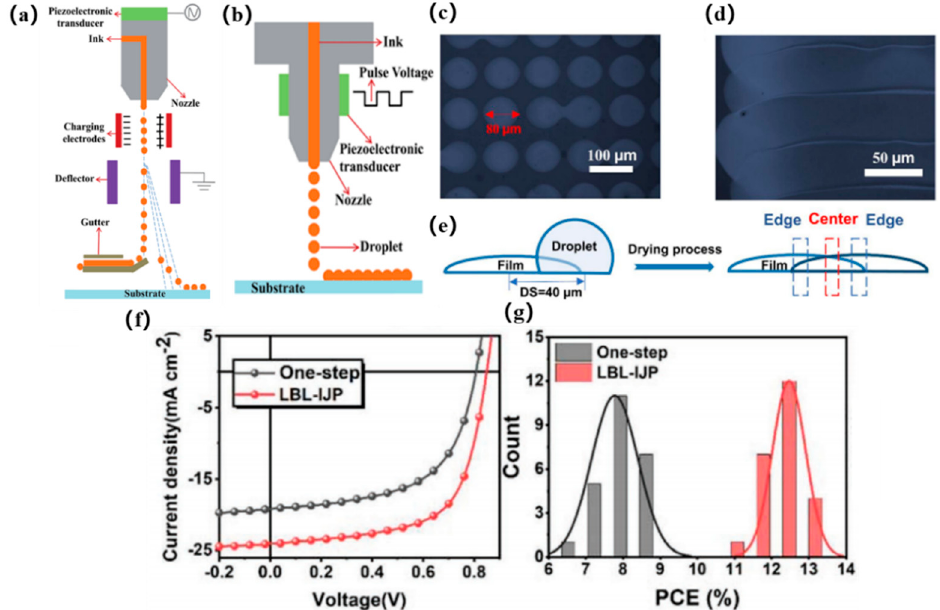
Figure 10. Schematic diagrams of ( a ) Continuous inkjet printing (CIJ), ( b ) Drop-on-demand (DOD) inkjet printing. Adapted with permission from Ref. [106]. Copyright 2019 The Royal Society of Chemistry; ( c , d ) Photographs of the ink drop and printed lines when printed at 50 ℃ . ( e ) The schematic diagram of droplet coalesces during inkjet printing with DS of 40 µm. ( f ) J − V curves of PBDB-T-2F: BTP − BO − 4Cl devices from one-step and LBL − IJP. ( g ) The histogram of the one-step and LBL − IJP processed OSCs. Adapted with permission from Ref. [61]. Copyright 2022 Wiley − VCH.